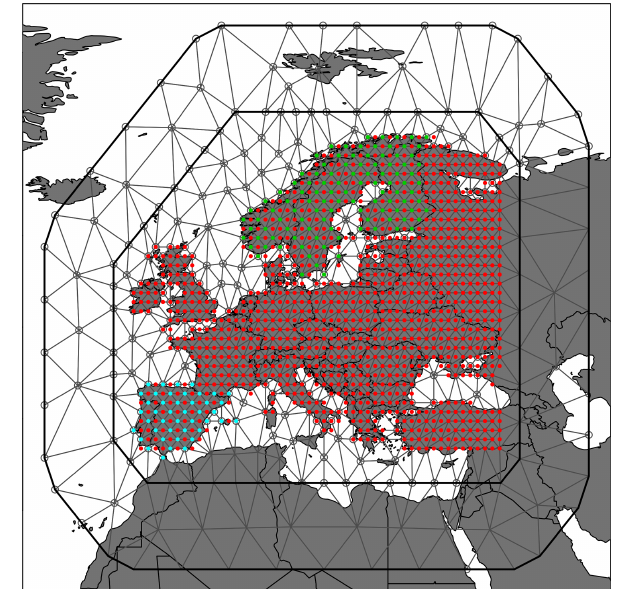
Figure 10. Triangular mesh with 711 mesh points for the 1 ◦ Eu- rope data set with data locations indicated in red, except locations included in the 1 ◦ residual analysis in Fig. 9 which are highlighted in blue for Iberia and green for